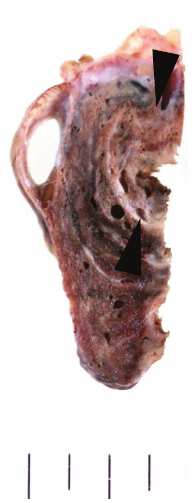
Figure 4: Invasive pulmonary aspergillosis with huge embolism. There is a huge embolism in the large vessel (black arrow head) with obstructive pneumonia. This was a case with long-term followup, and the annual ring can be seen in the embolism.